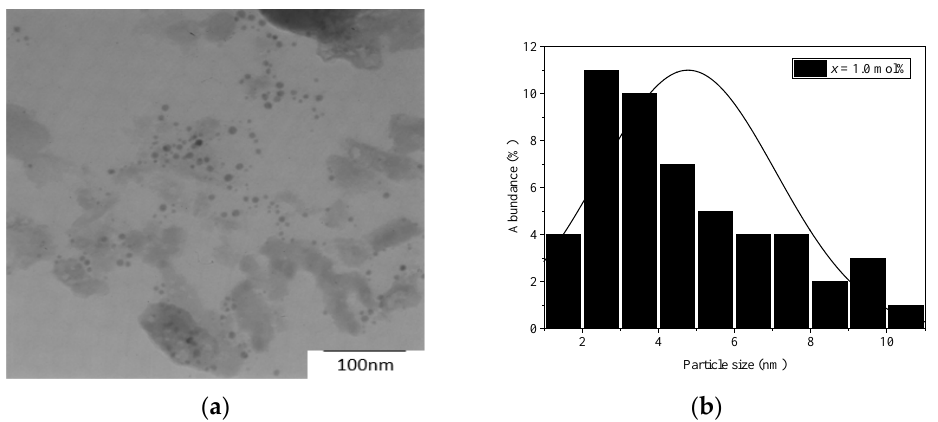
Figure 2. ( a ) TEM image with 100 nm magnification of glass with 1.0 mol% vanadium; ( b ) histogram of size distribution of metallic silver NPs.